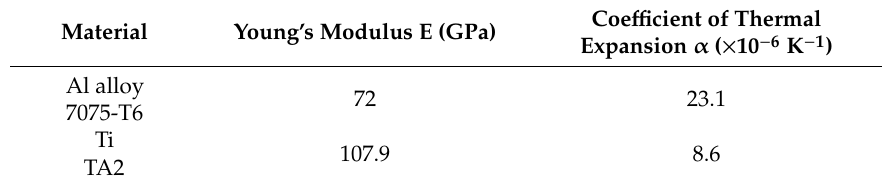
Table 1. Material properties for the aluminum alloy [43], and titanium